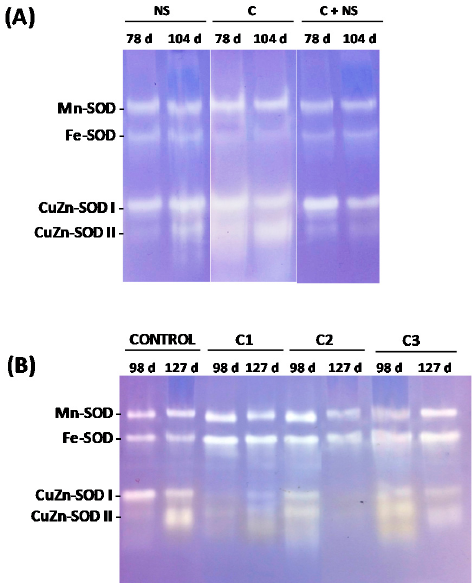
Figure 1. Profiles of the SOD isozymes from pepper leaves (Mn-SOD, Fe-SOD, CuZn-SOD I and CuZn-SOD II) obtained after treatments under different AL compost conditions. Proteins (50 µg per well) were loaded, separated by native-PAGE (10% acrylamide), and stained by the NBT photochemical method. ( A ) Exp. No. 1; NS, plants grown with full nutrient solution; C, plants only grown with compost; C + NS, plants grown with compost and complemented with full nutrient solution. ( B ) Exp. No. 2; Control, plants grown with full nutrient solution; C1, C2, and C3, plants